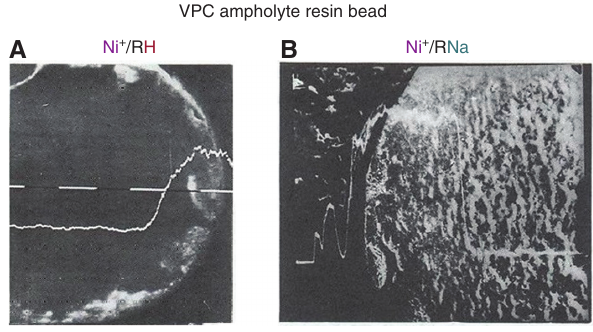
Figure 9 (A, B) Experimental SCM micropictures, binary i/j IEX: propagation of incoming Ni concentration waves to the center of the r- bead: to the left (A); to the right (B), VPC ampholyte resin (Russia). Light lines: Ni + concentration waves-profiles. Micropictures, two kinds of IEX: spreading Ni + wave (nonselective IEX, A); sharp Ni + wave (selective IEX, B)